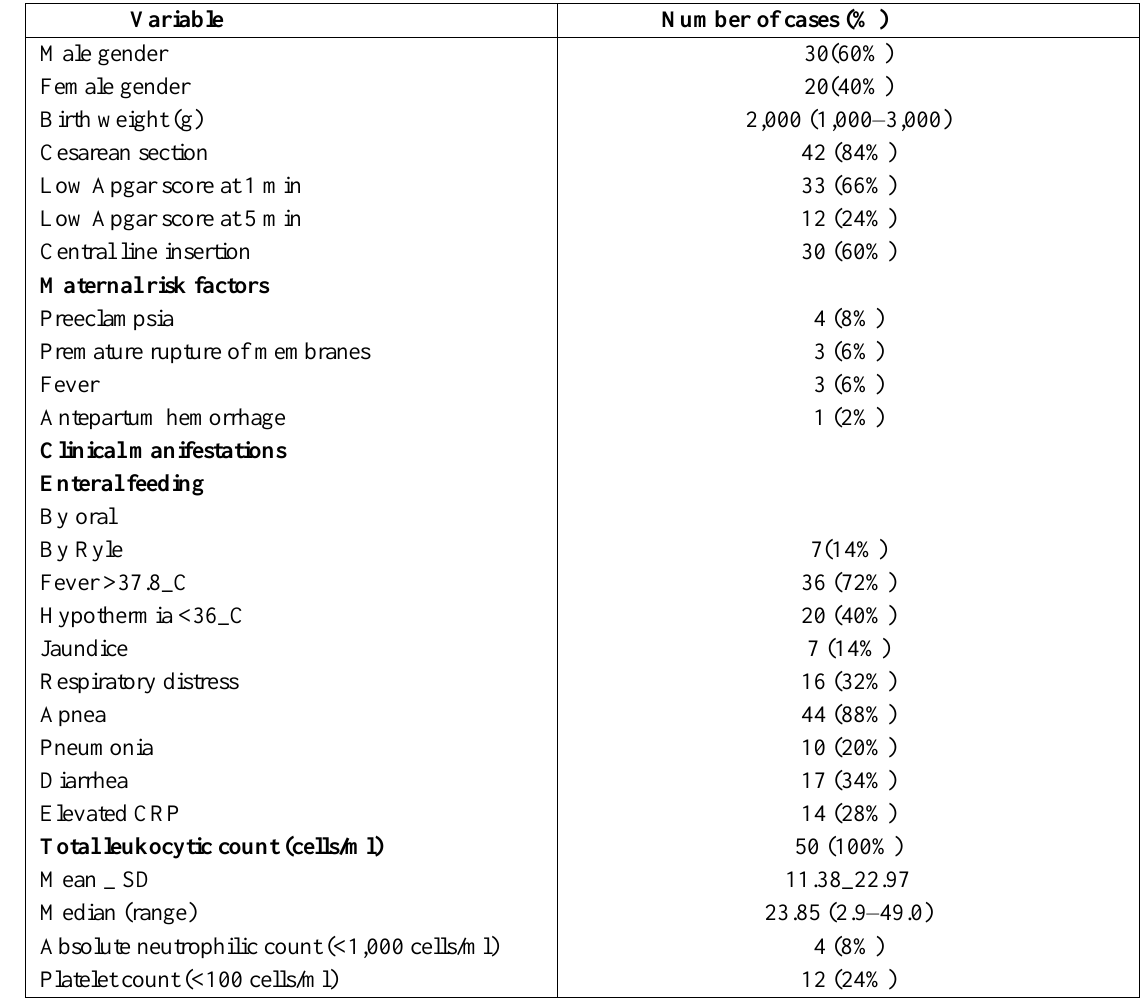
Table 1. Demographic and clinical data of the study